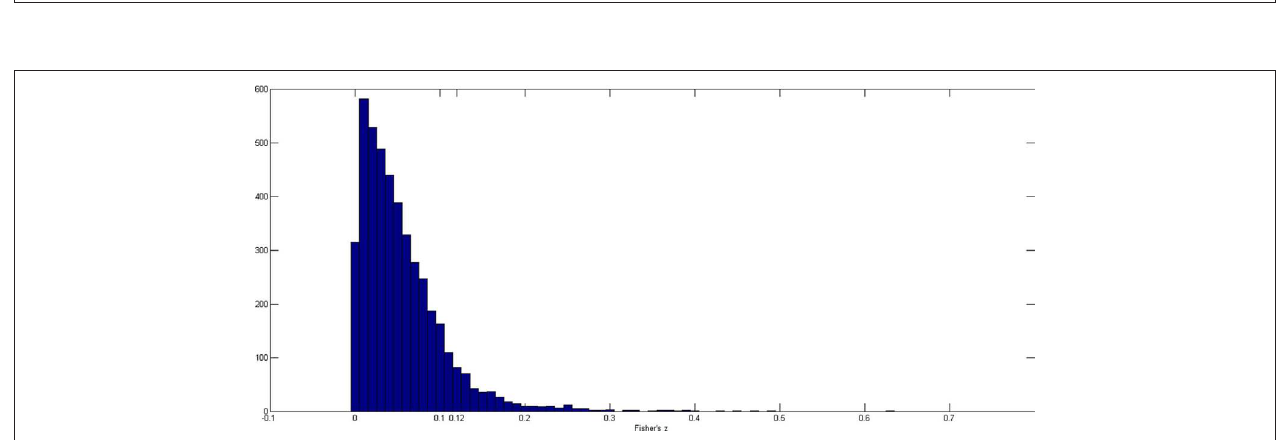
FIguRe A3 | The histogram for absolute partial correlation (Fisher’s z ) values of one subject in the left task-related network.